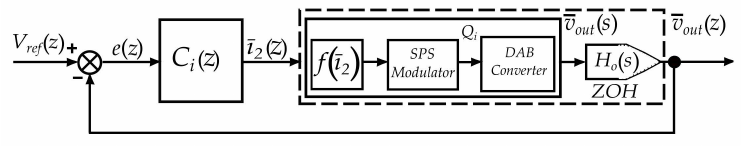
Figure 8. Detail view of the proposed voltage control